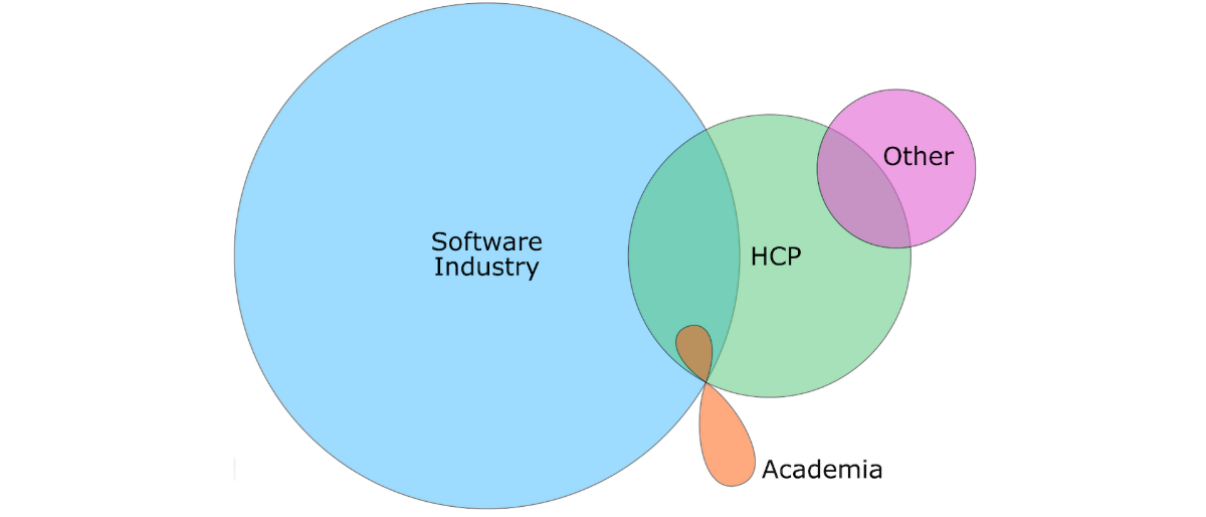
Figure 2. Diagram illustrating the distribution of different authors involved in the development of the medication management apps. The overlapping regions indicate the apps codeveloped by 2 or 3 different author affiliations (combinations). HCP: health care